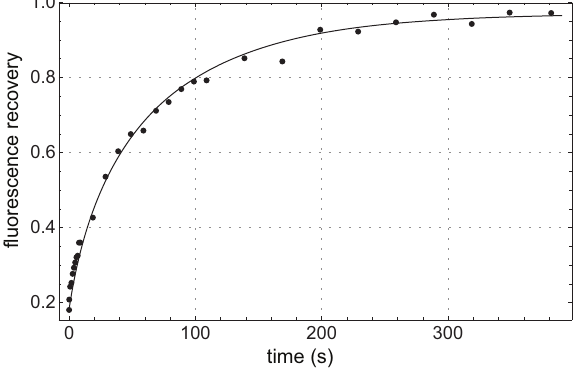
Figure 4. FRAP time series. A typical FRAP recovery time series (dots), following the relative TetA-YFP fluorescence in the bleached region of interest (ROI) in a cell of DGC103 after bleaching, which was calculated as described in Methods. The fitted theoretical curve (line) yields D =0.101 m m 2 /s and K =0.97.